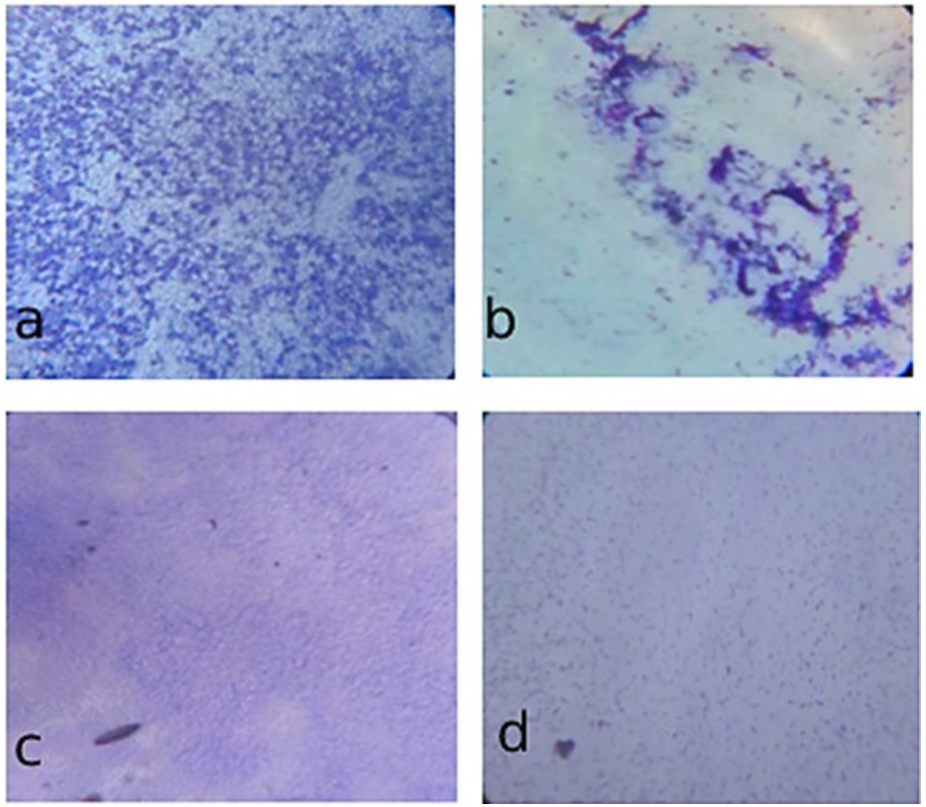
Fig. 8A. Light microscopic observation of inhibitory effects of Chitosan/Hydroxyapatite nanocomposite on biofilm formation (a). Streptococcus mutans - control; (b) Streptococcus mutans - test; (c). E. coli - control; (d). E. coli -